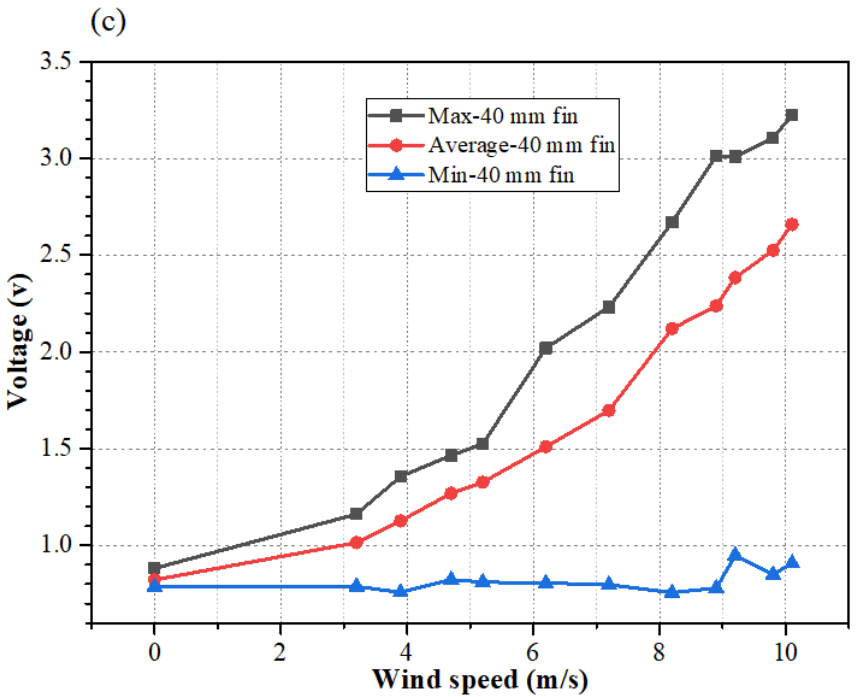
Figure 7. Maximum, minimum, and average values of voltage signals versus wind speed under fin sizes of ( a ) 20 mm; ( b ) 30 mm; ( c ) 40 mm.